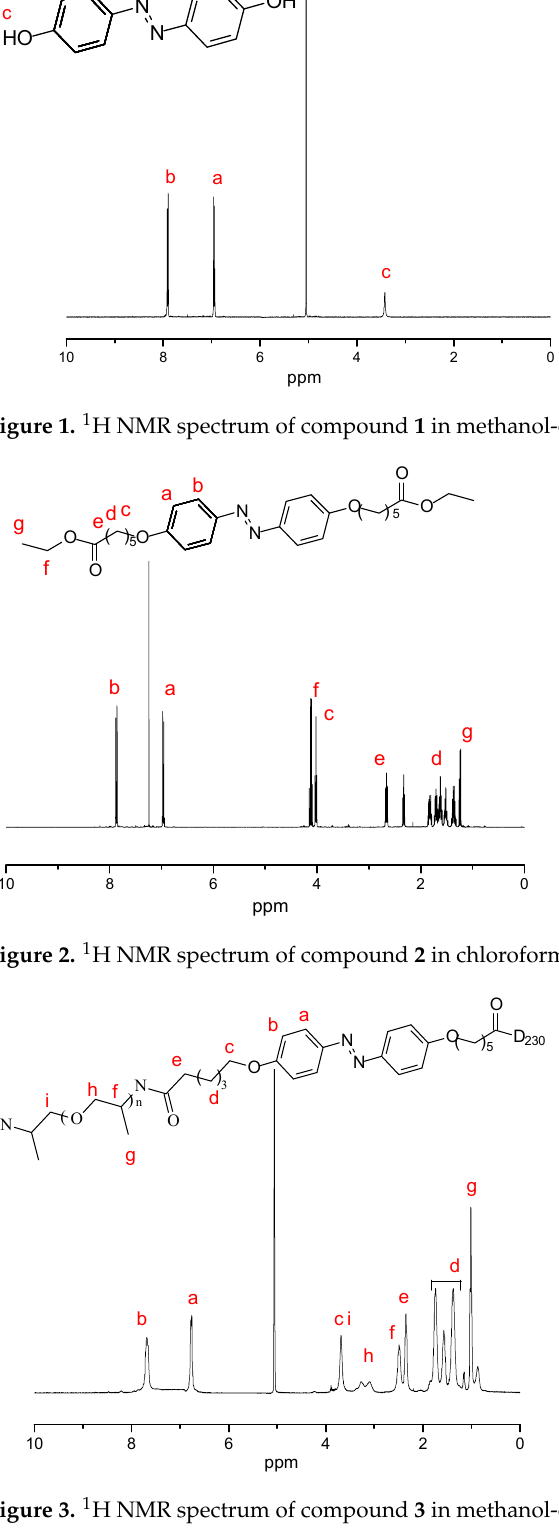
Figure 3. 1 H NMR spectrum of compound 3 in methanol-d4.